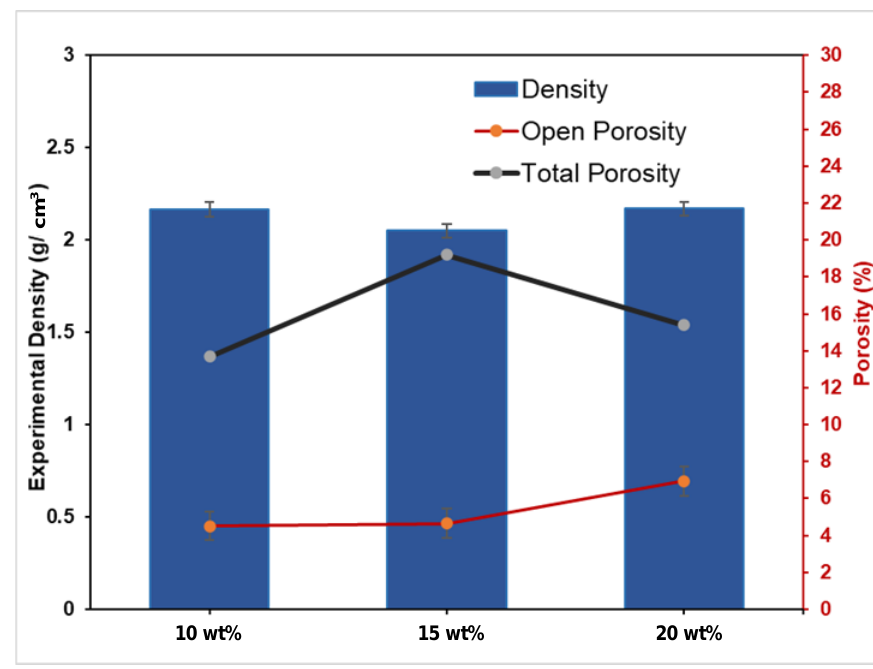
Figure 4. Graph of experimental density and open porosity against RHA composition.